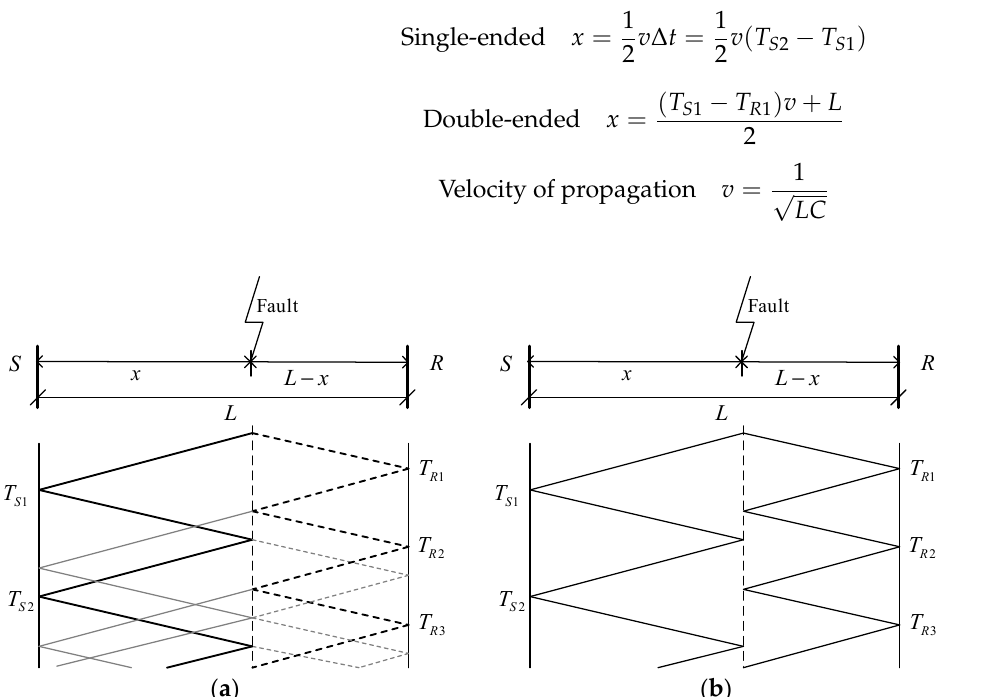
Figure 1. Lattice diagrams of ( a ) grounded fault and ( b ) ungrounded fault.